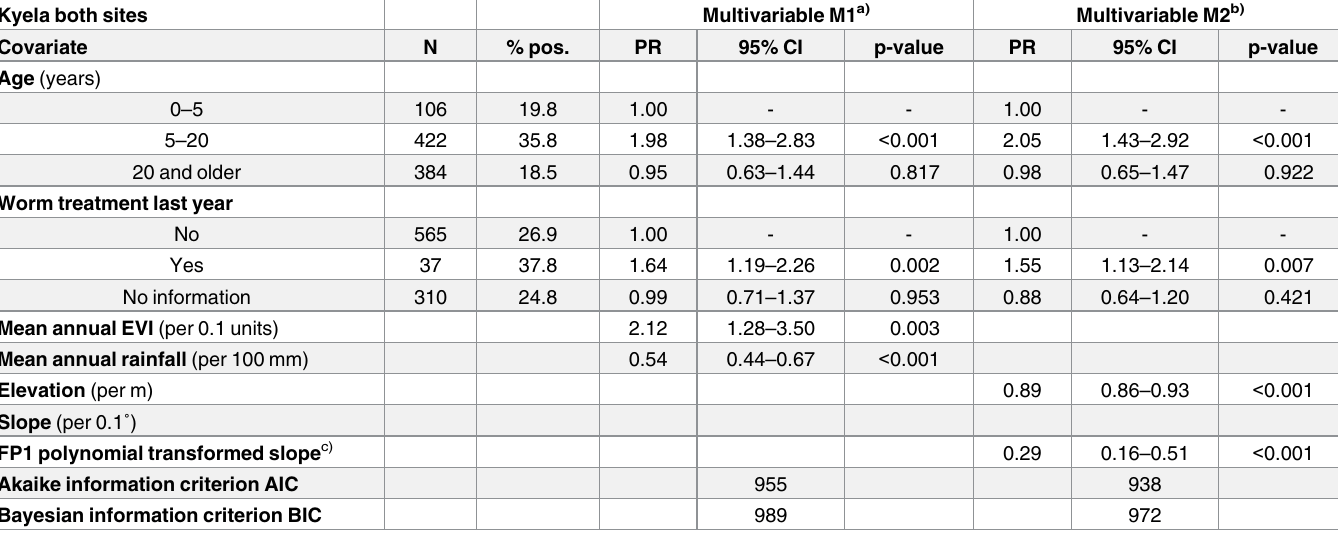
Table 3. Multivariable association of different factors with T . trichiura infection in Kyela. Results of multivariablePoissonregression models adjusted for household clustering using robust varianceestimates (N = 912). Multivariable results are only shown for those variablesthat were includedinto the respec- tive